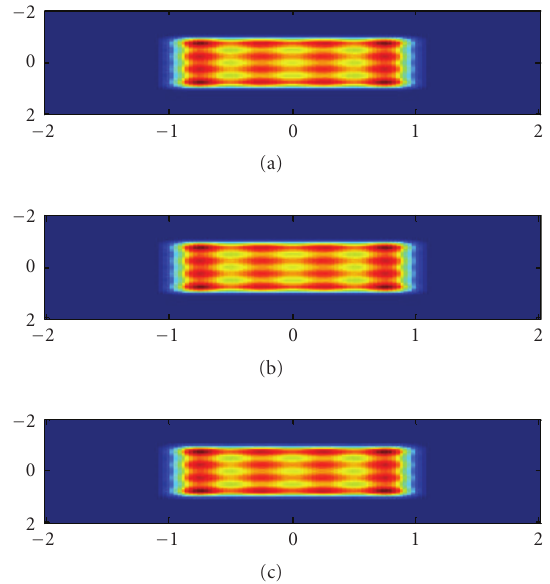
Figure 3: Wave intensity distributions after a phase object. (a) Right behind the grating G1; (b) At the first Talbot distance; (c) At the first Talbot distance by the first-order approximation. The spatial unit is μ